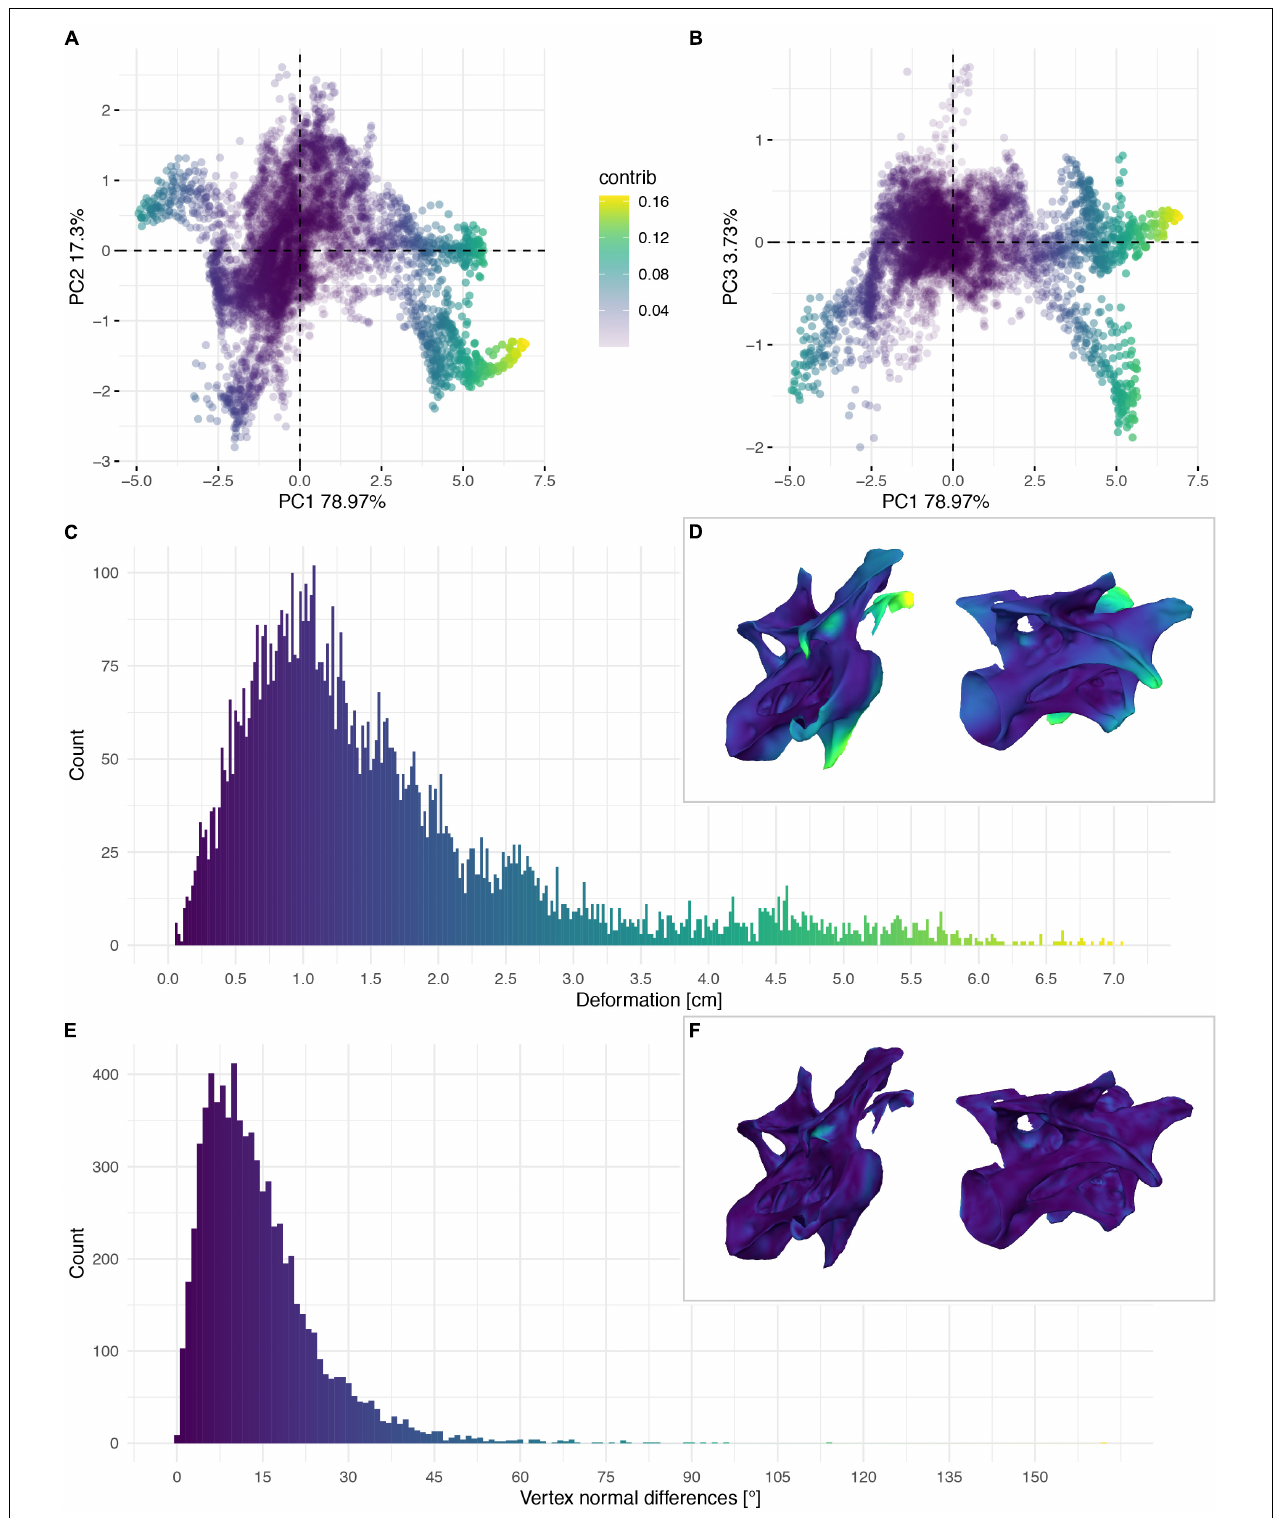
FIGURE 8 | Deformation of CV 9 of Galeamopus pabsti SMA 0011/NMZ 1000011. PCA of the differences in the components of the vector between corresponding vertices (A,B) . PC1 represents the major axis of deformation. Histograms of the absolute deformation (morphological distance) between the trimmed reconstruction and the exposed original specimen (C) and the angles between the different orientations of the corresponding vertex normals (E) . Visualisation of the deformations in oblique views (D,F) .